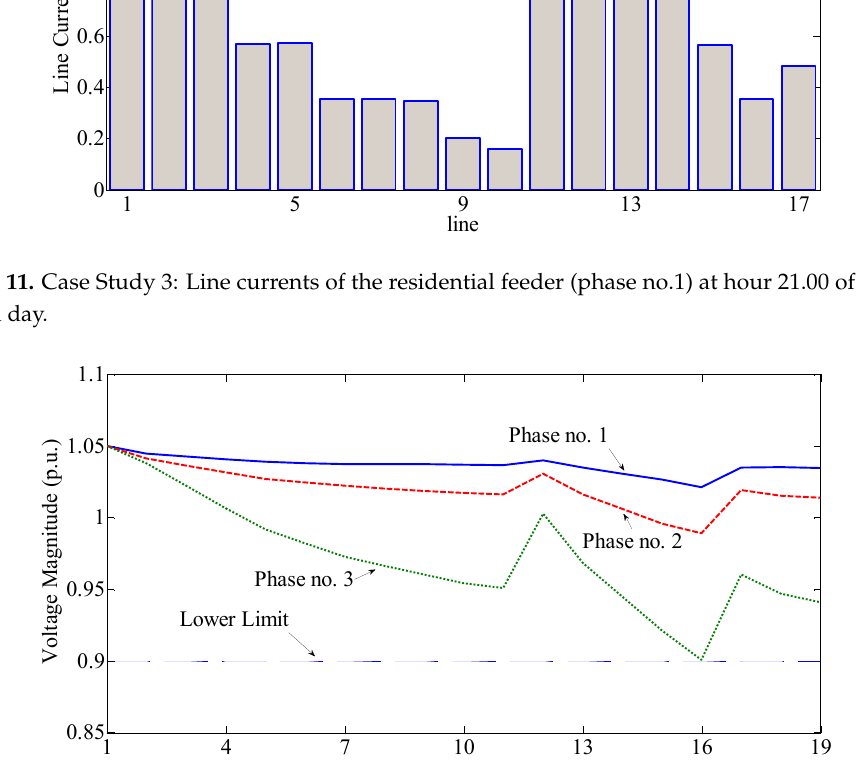
Figure 12. Case Study 3: Voltage magnitude of the residential feeder at hour 21.00 of the last typical